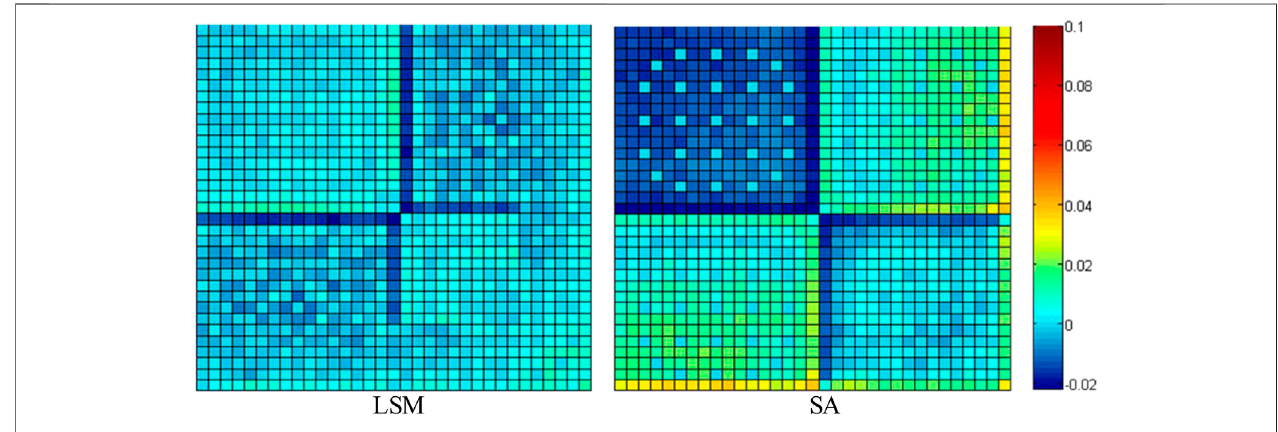
FIGURE 7 | Pin-power relative error distributions.